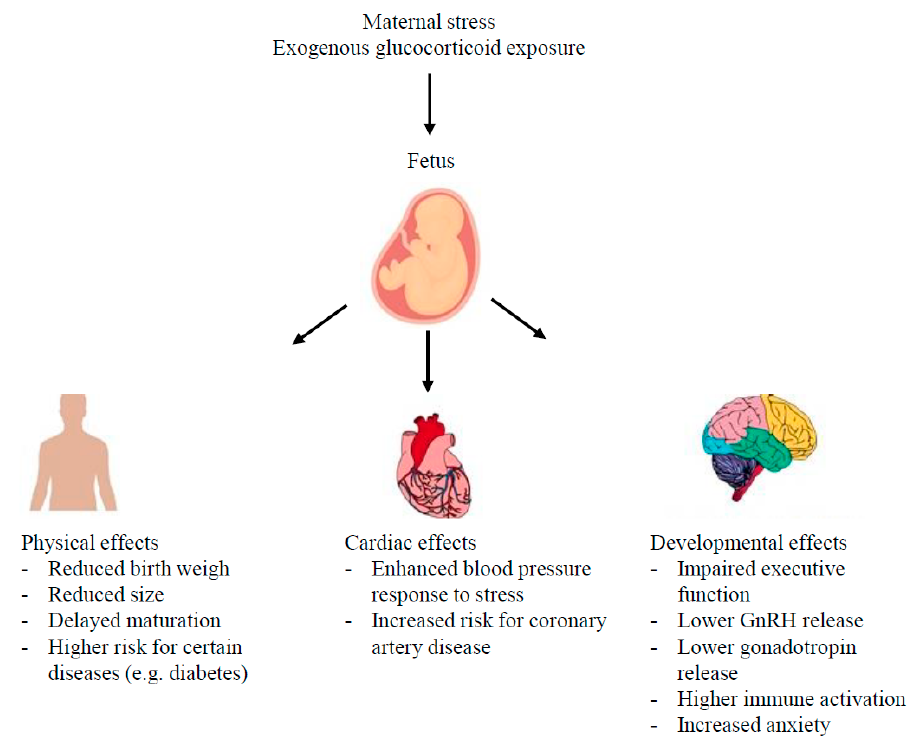
Figure 2. High levels of glucocorticoids experienced in utero through stress or exogenous administration can cause effects in the organ systems of